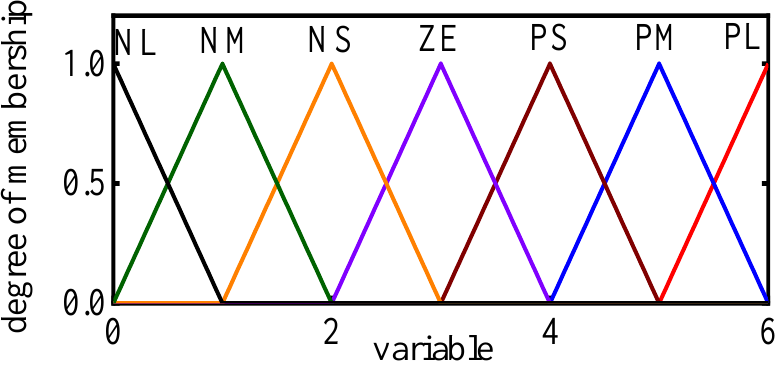
60 . 0 2 4 variable 60 . Figure 5. Membership function graph. 0 2 4 variable Figure 5. Membership function Figure 5. Membership function graph.